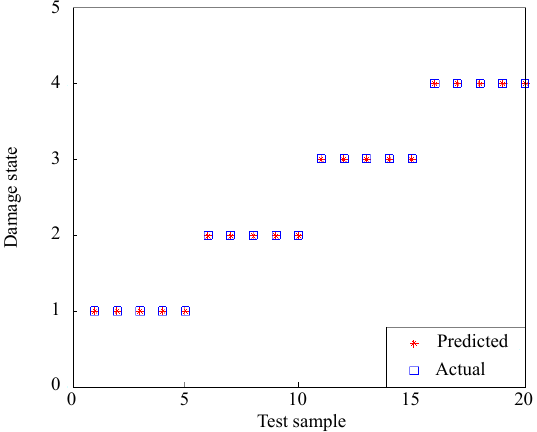
Fig. 10 Predicted results of the BP neural